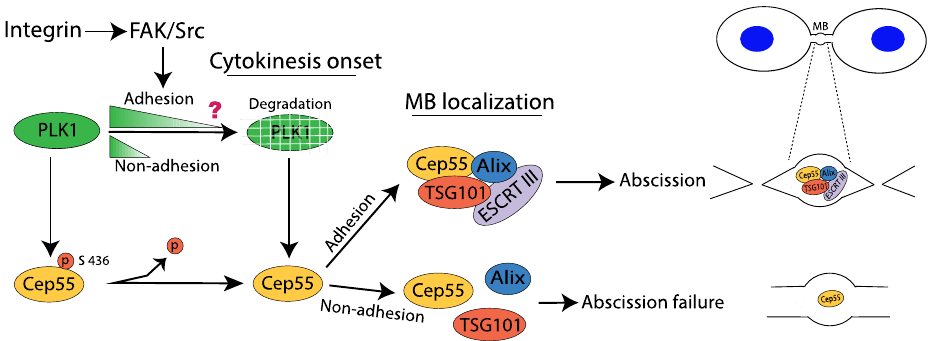
Figure 6. A proposed model for the role of integrin-mediated adhesion signaling via FAK and Src in cytokinesis abscission. Adhesion is indicated to delay the degradation of PLK1 and, thereby, prevent premature recruitment of Cep55 to the midbody; the details of this mechanism are incompletely known. In the absence of adhesion, Alix and TSG101 do not bind to Cep55 and the abscission process cannot proceed